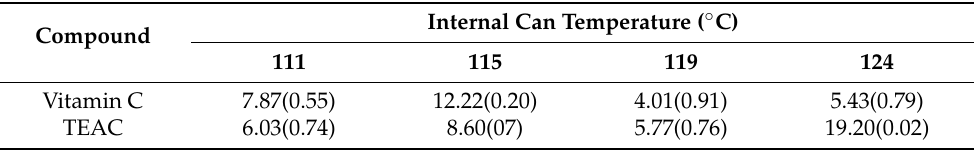
Table 1. Goodness of fit test statistics ( X 2 ) , and associated significant probabilities (in parenthesis) of the fitted curves for vitamin C and trolox equivalent antioxidant capacity(TEAC) at different internal can temperatures for the different thermal treatment durations shown in Figure 5.